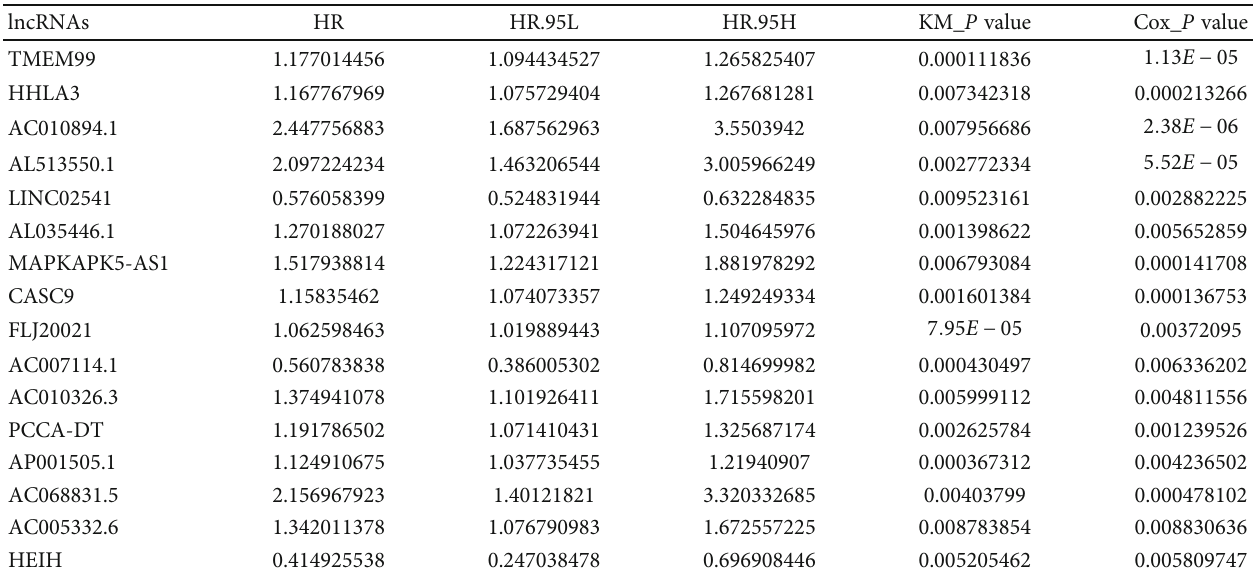
Table 1: Identi fi cation of m7G-related prognostic lncRNAs.